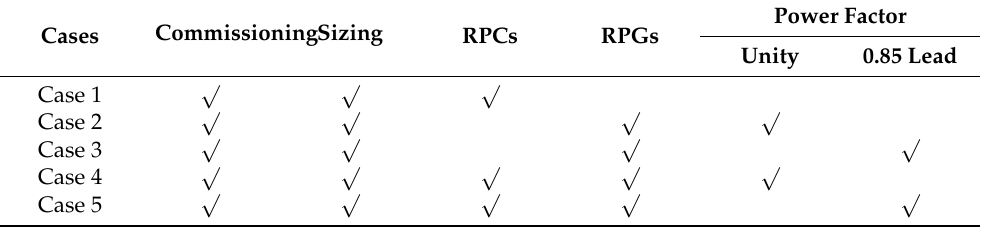
Table 2. Test cases and their